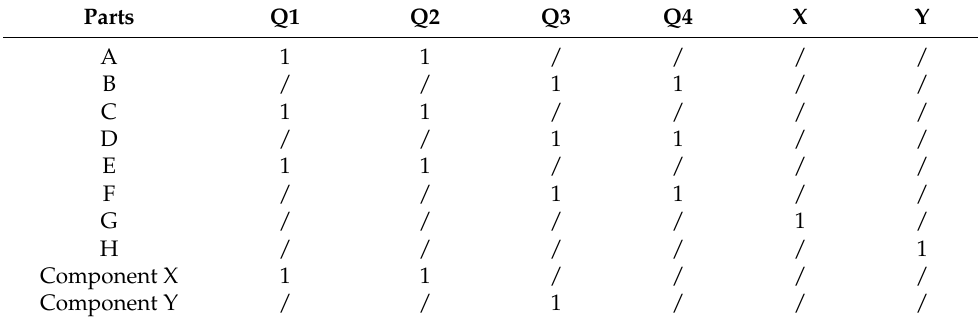
Table 1. Product demand matrix.